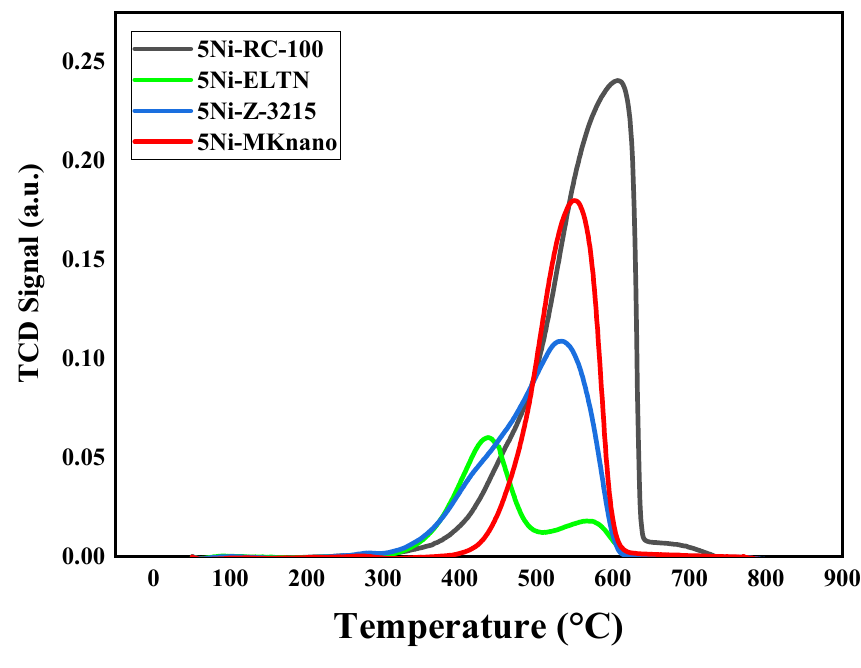
Figure 10. TPO analysis of the used catalysts.